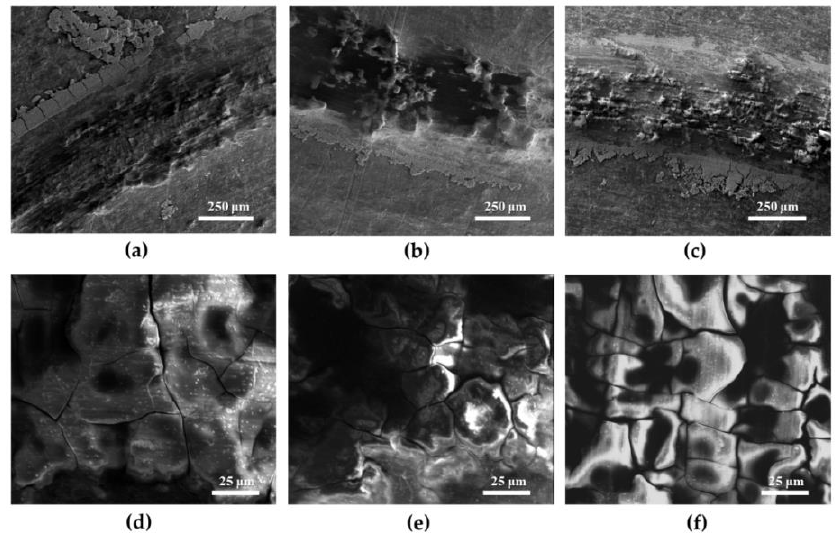
Figure 7. Wear tracks of the GHA/Si 3 N 4 system. Low magnification of: ( a ) GHA10, ( b ) GHA50 and ( c ) GHA100. High magnification of the inner details: ( d ) GHA10, ( e ) GHA50 and ( f ) GHA100.